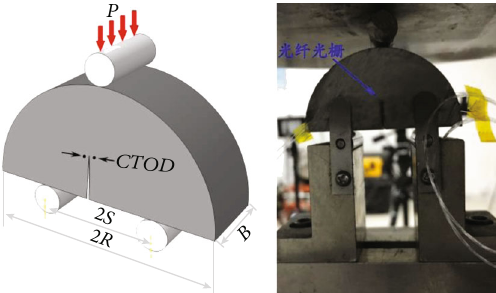
Figure 2: Coal SCB specimen [20].